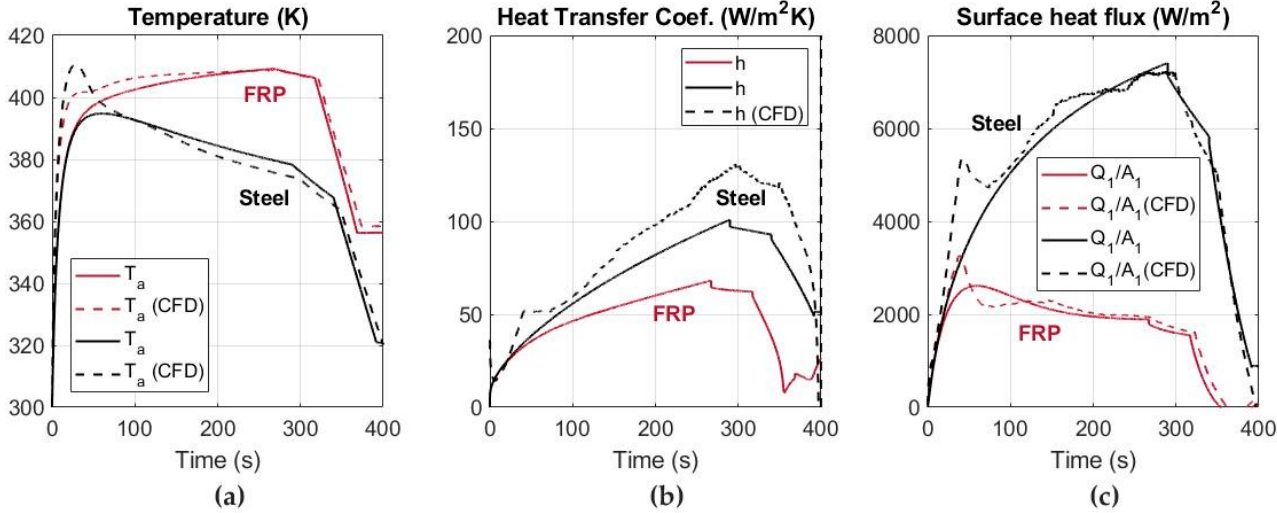
Figure 15. Comparative analysis between analytical and numerical models in the first cycle considering FRP and steel as sealing layers. ( a ) Air temperature; ( b ) Heat transfer coefficient; ( c ) Surface heat flux.